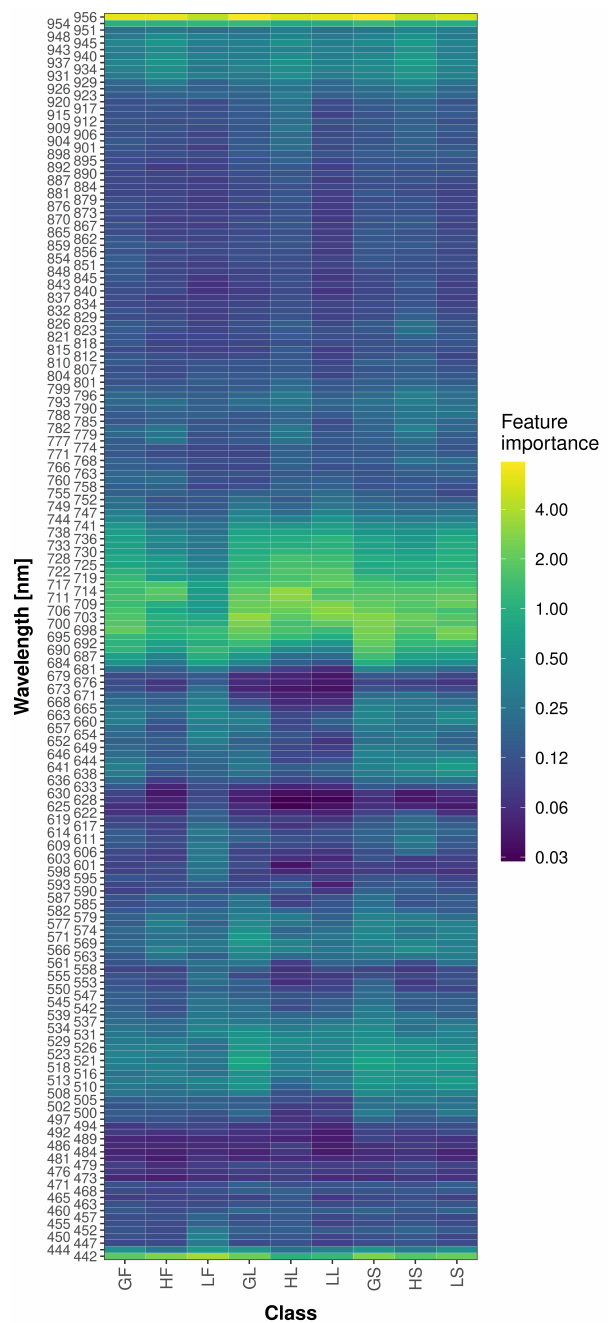
Figure 7. Feature importance for each predictor based on the different classes, obtained from the baseline variant. First character: G = grass, H = herb, L = legume. Second character: F = flower, L = leaf, S =